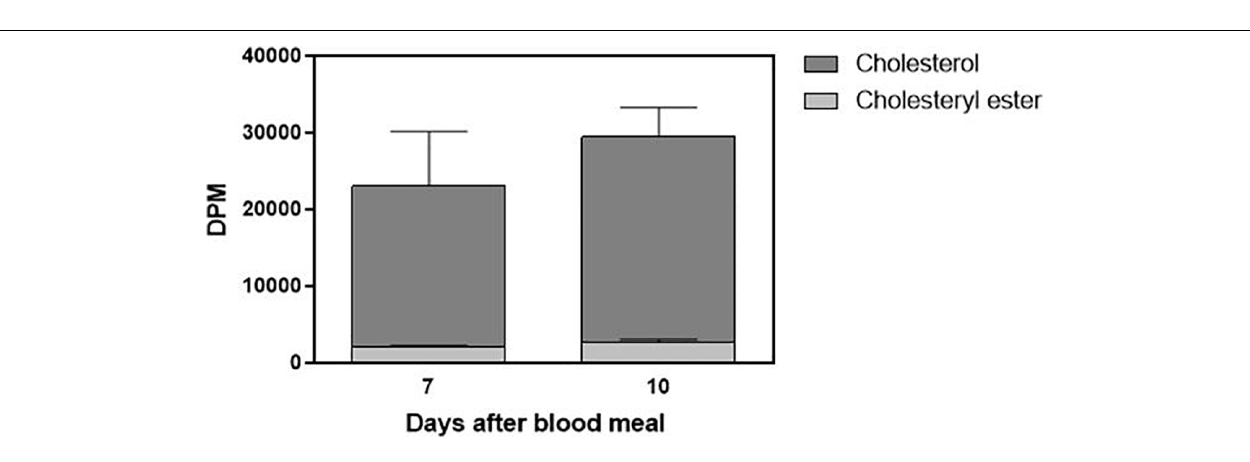
FIGURE 5 | Part of ingested cholesterol is excreted in feces. Feces (total amount produced after feeding) from Rhodnius prolixus adult females fed on 3 H-cholesterol-enriched blood were collected on the seventh and 10th days after the blood meal. Lipids were extracted from the feces and were analyzed by HPTLC. Radioactivity associated with free cholesterol (dark bars) and esterified cholesterol (light bars) was quantified and expressed as DPM/total feces ± SEM from three to four determinations. p > 0.05 by the Mann–Whitney test. HPTLC, high-performance thin-layer chromatography; DPM, disintegrations per